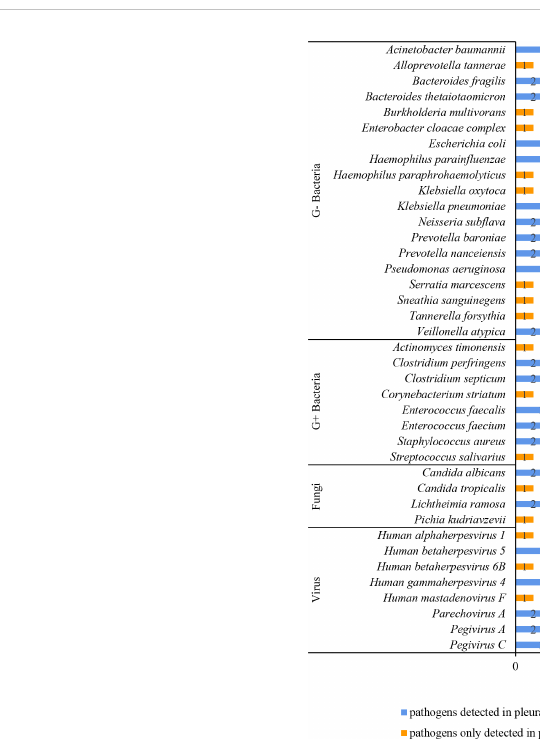
FIGURE 4 Pathogen spectrum detected by mNGS in different sample types.